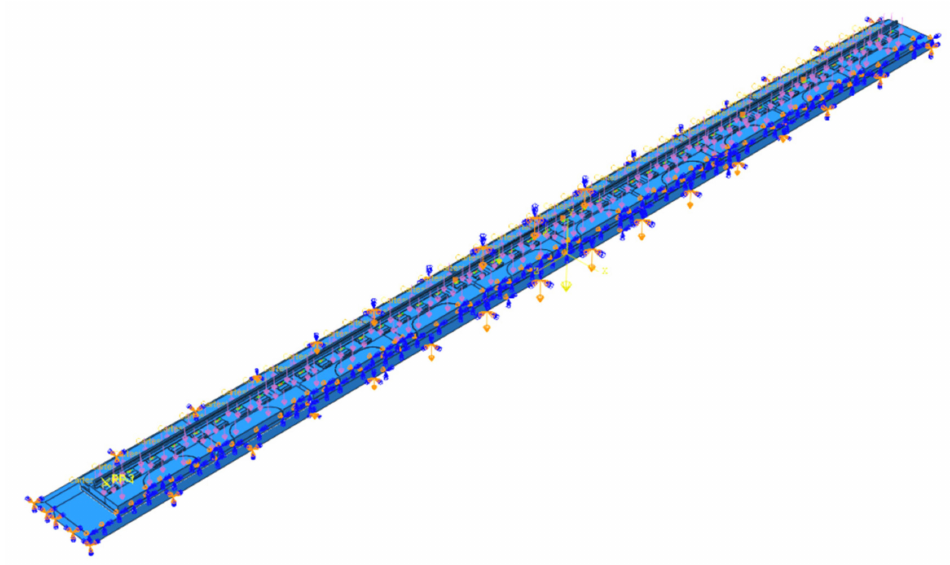
Figure 7. Finite element model of track structure under uneven settlement.